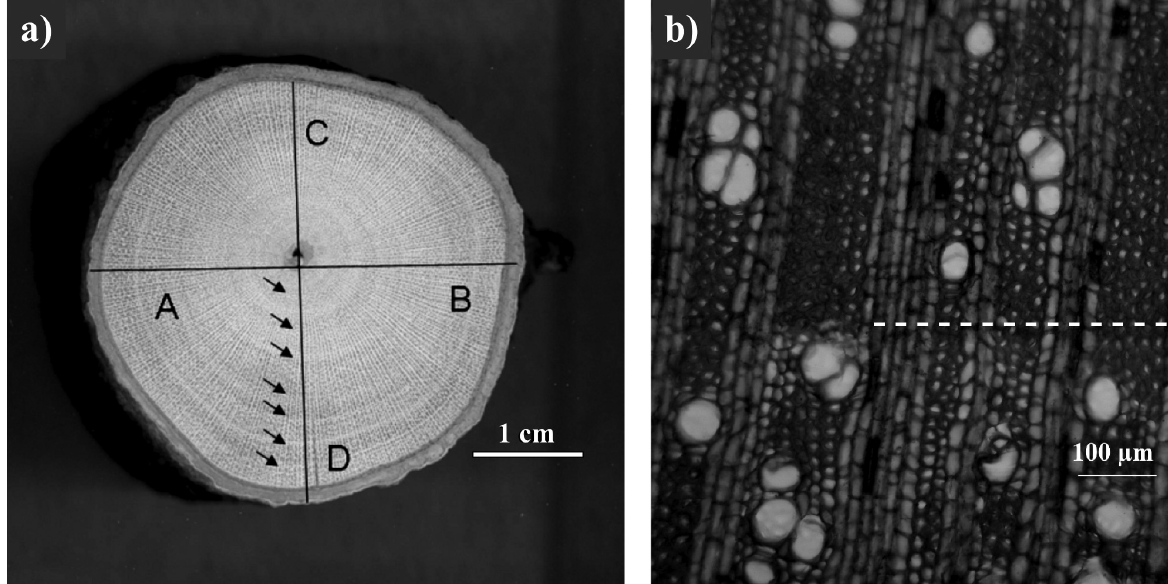
Figure 2 – Macro - ( 2a ) and microscopic ( 2b ) aspects of the growth rings observed in R. mangle . In a ), the black lines represent the transects (A, B, C, and D) and the arrows indicate the growth rings boundaries. In b ), the dashed line indicates the limit between a latewood (below) and an earlywood